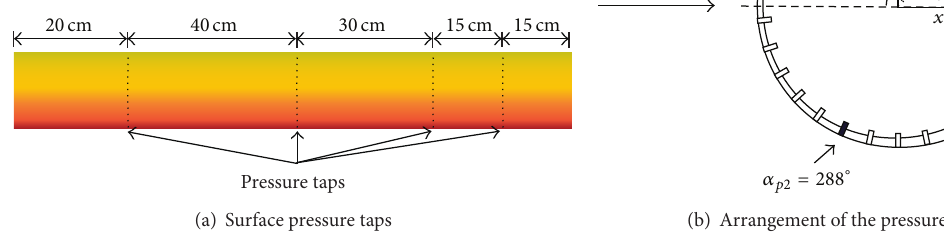
Figure 3: Pressure tap arrangements.